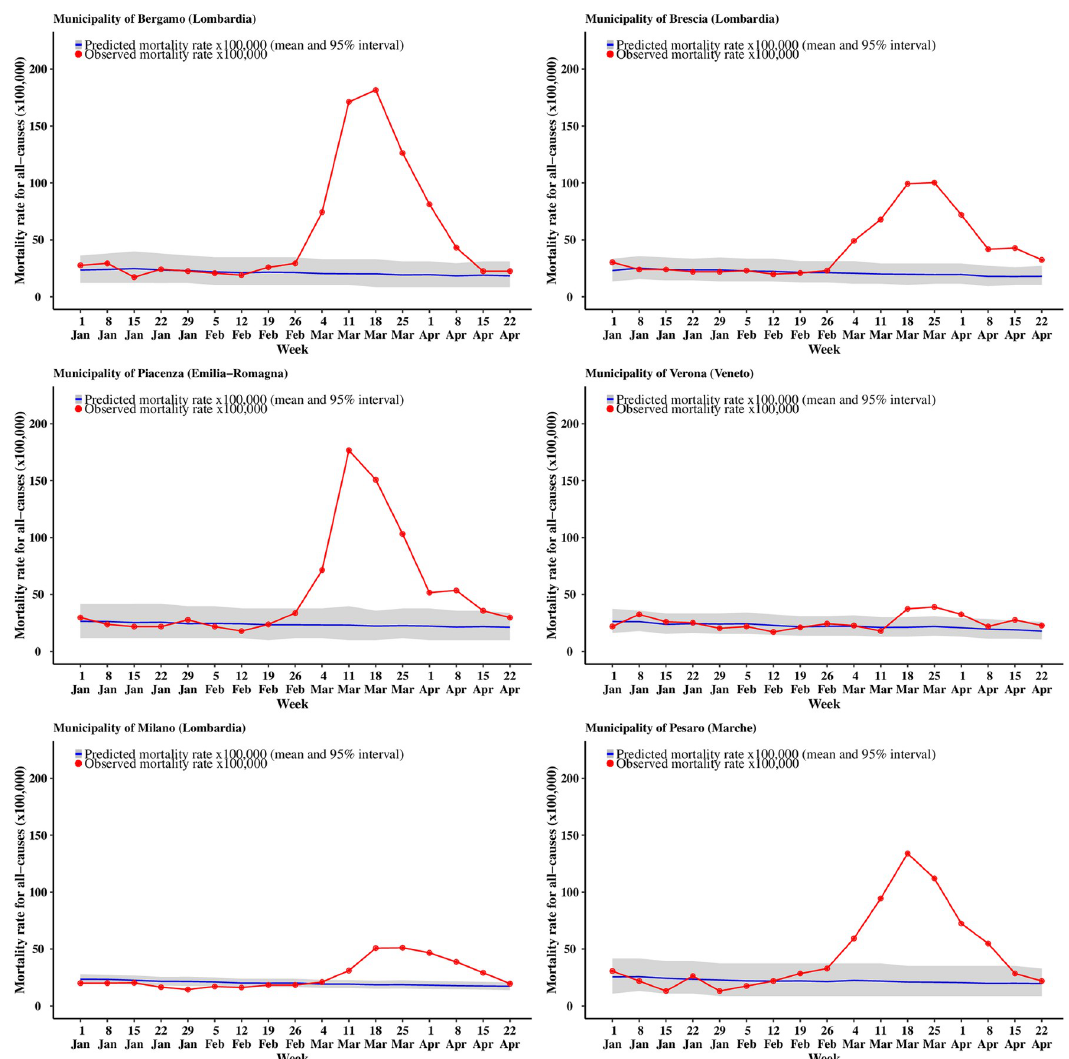
Fig 5. Trend for all cause mortality (males) in selected municipalities. The blue curve shows the posterior predictive mean predicted from the 2016–2019 model, while the gray ribbon describes the posterior 95% interval; the observed number of deaths for 2020 are in